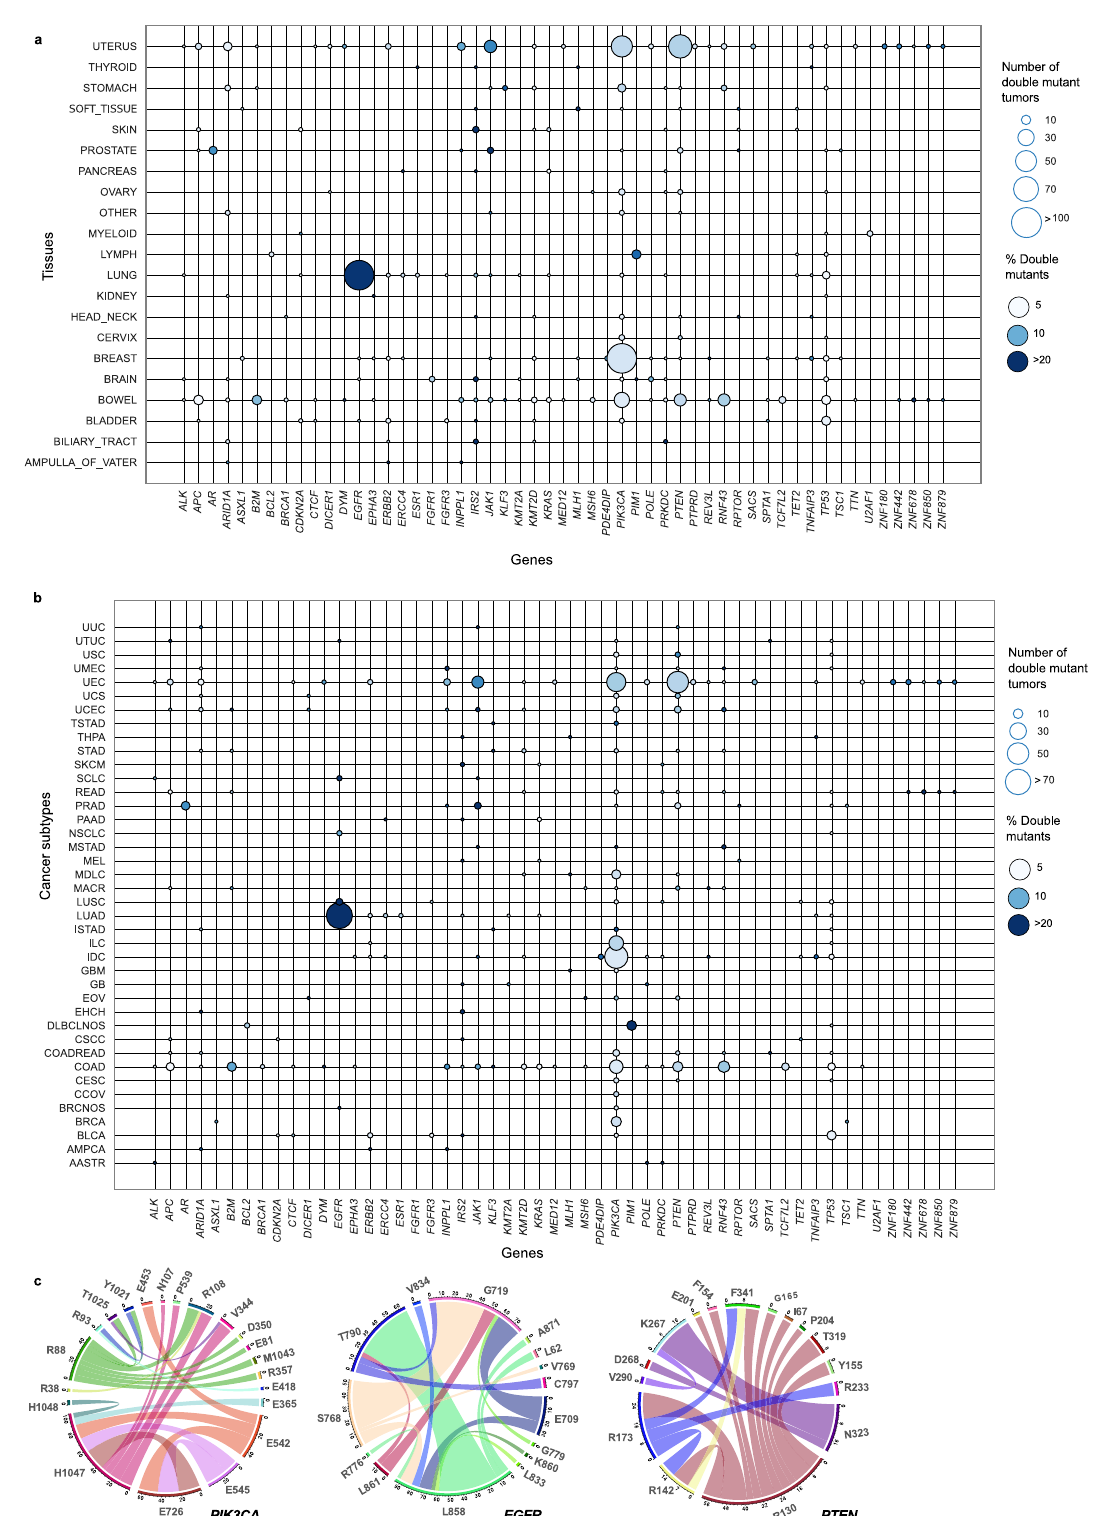
Fig. 2 Same gene double mutations are speci fi c to some tissues or cancer subtypes. Bubble plots show number (node size) and frequency (node color) of double-mutant tumors among gene-mutant tumors across different tissues and cancer subtypes (Oncotree). For the 53 genes with signi fi cant same gene double mutations, node size represents the number of patients carrying at least one doublet in a gene in a tissue or cancer type. a Presence of same gene double mutations across different cancer tissues where at least three tumors carry at least one same gene double mutation in one of the 53 genes. b Presence of same gene double mutations across different cancer subtypes. The cancer subtypes where at least fi ve tumors carry at least one double mutation are listed on the y -axis. c Representation of mutations in genes to compose a doublet as a circular diagram. The strips from one residue to another represent signi fi cant double mutations with size of strips indicating frequency of each double